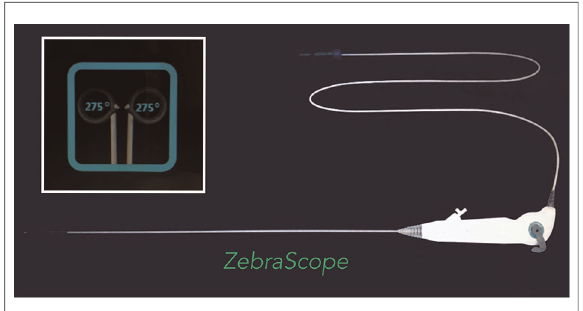
FIGURE 1 Zebrascope was composed by scope handle, scope body and data wire. There was an entrance on the handle through which the laser fi ber was introduced into the scope body. During the procedure, the surgeon could rotate the handle and curve the fl exible tip of the scope body up and down through the controller on the handle.